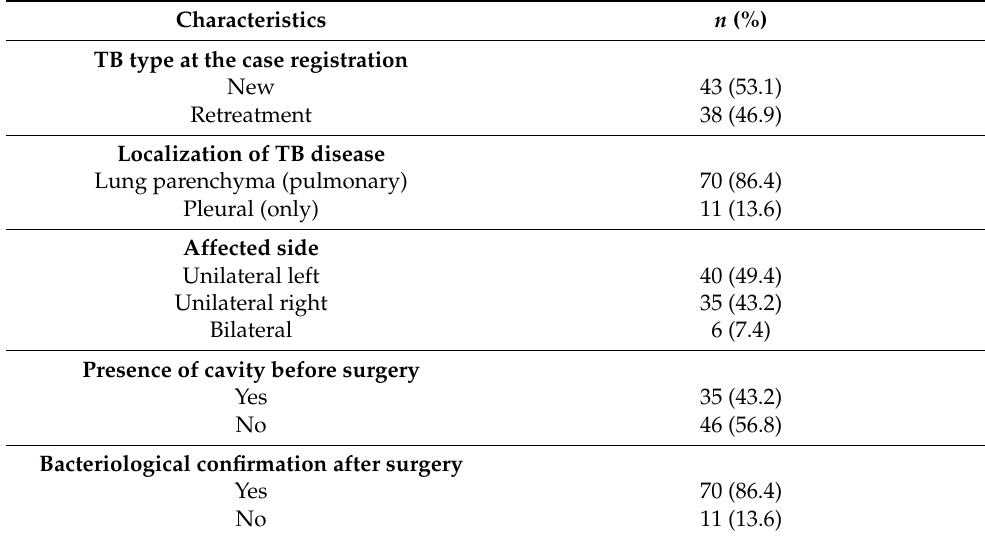
Table 5. Clinical characteristics of patients with histological confirmed active tuberculosis after surgery was performed at RSSPMCPP in Uzbekistan from January to May 2017 ( n = 81).